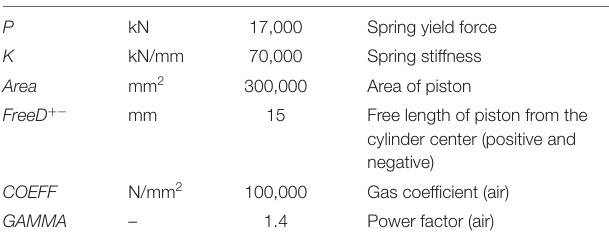
parameters for the semi-active spring model are shown in Table 4 .